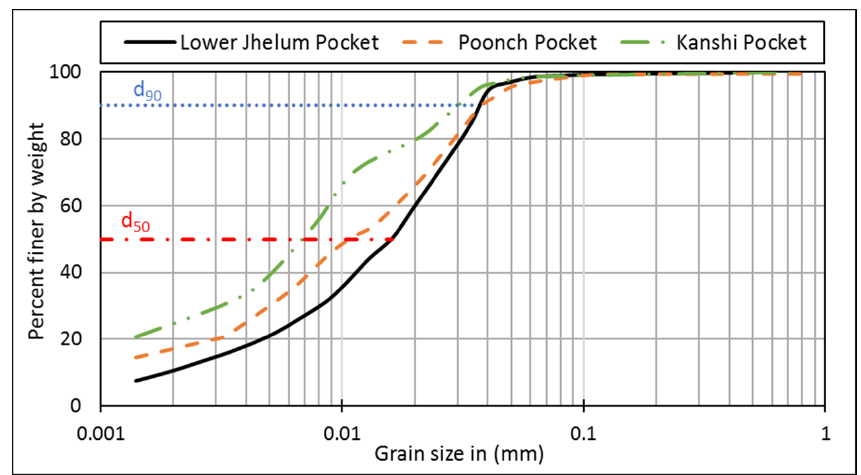
Figure 6. Bed gradation curve of different Mangla pockets.